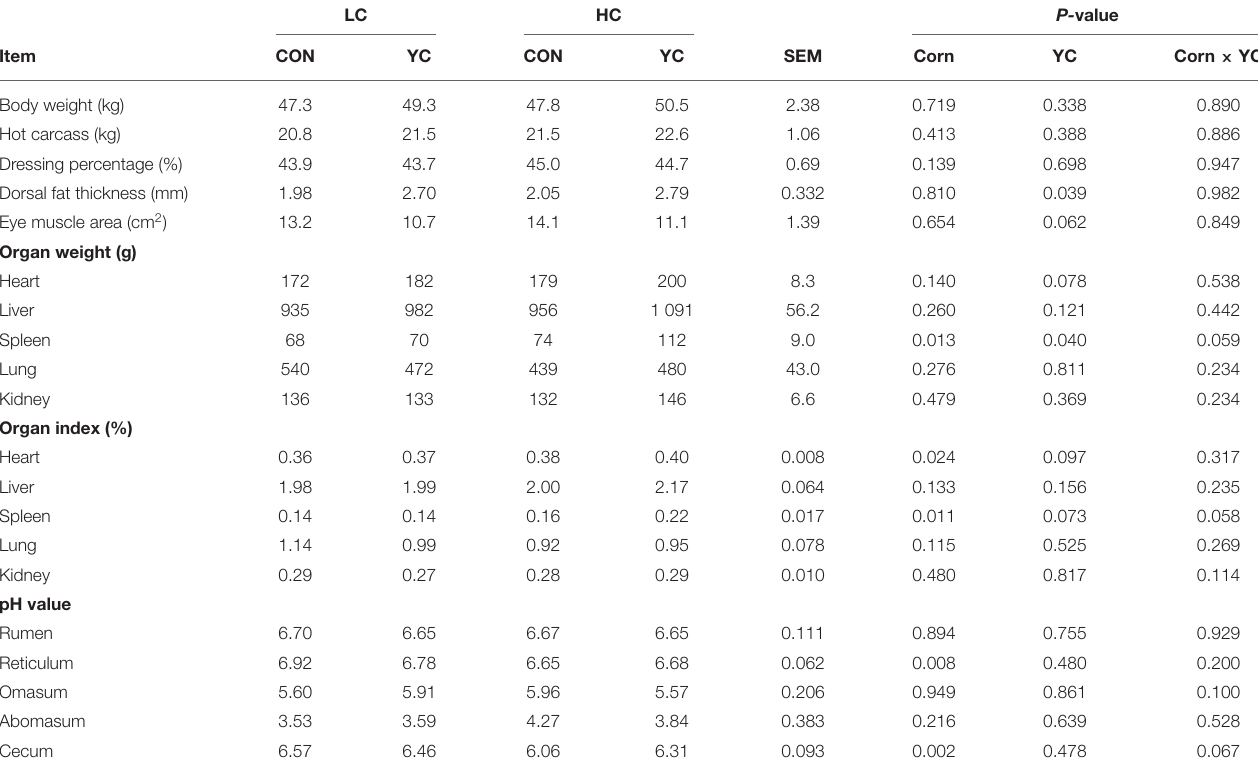
TABLE 6 | Slaughter performance, organ weights and indexes, and digestive tract pH values of fattening lambs fed experimental diets containing a low (LC) or high (HC) proportion of corn and supplemented with nil (CON) or yeast culture (YC) ( n = 6 per treatment). LC HC P- value